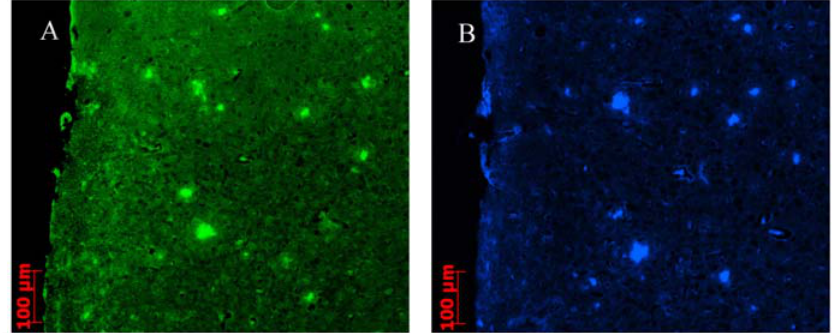
Figure 4. The labeled plaques were confirmed by staining of the adjacent sections by thioflavin-S ( A ); Fluorescence staining of compound 8 on AD model mouse sections from the cortex ( B